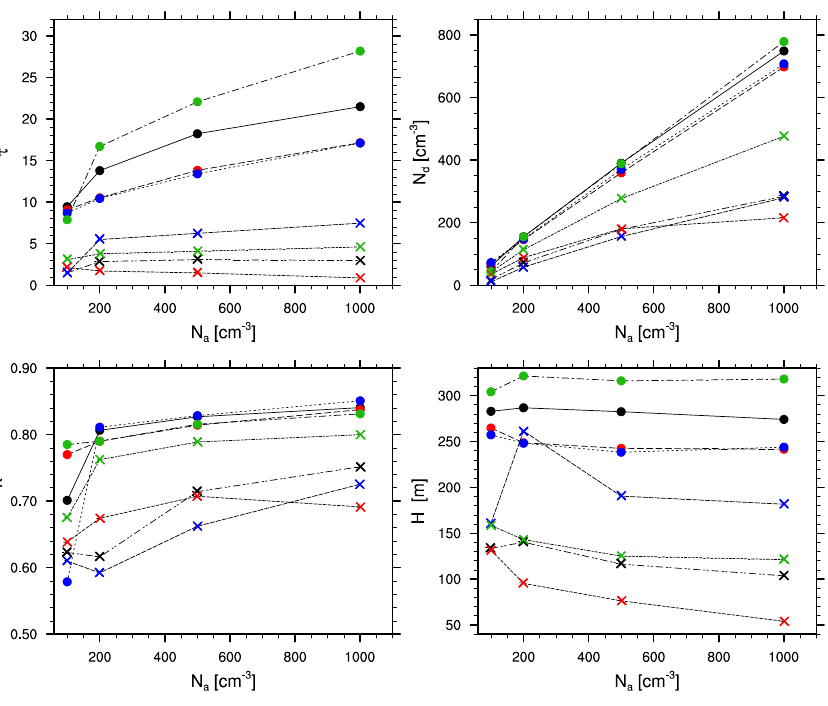
Fig. 12. Averaged optical depth ( τ ), cloud droplet number concentration ( N d ), dispersion coefficient ( k ) and cloud thickness ( H ) as a function of aerosol number concentration N a . Values are averaged horizontally and vertically between cloud top and base for Control (black), SST290 (red), QFT3 (blue), and DIV3 (green) cases during nighttime (averaged over 4–7 h, filled circle) and daytime (average over 12–15 h, cross).